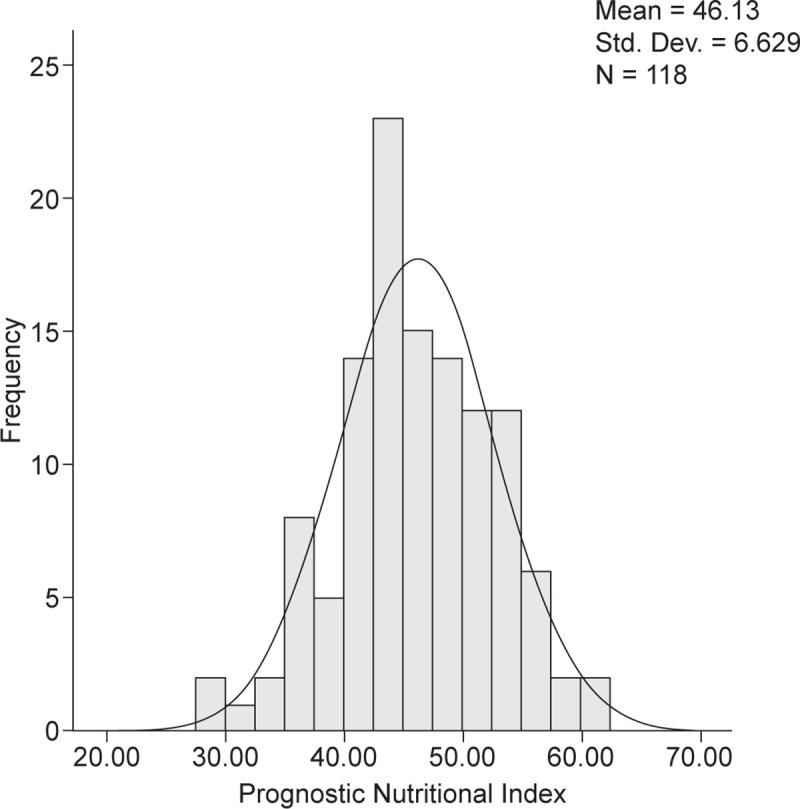
Distribution of the preoperative PNI in resected AoV cancer.